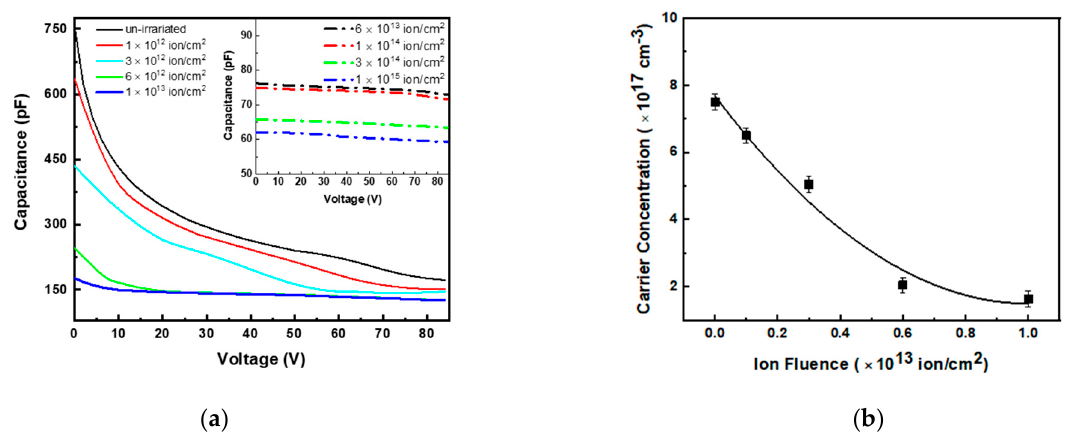
Figure 4. Capacitance–voltage (C–V) curves of un-irradiated and of irradiated diodes at different fluences ( a ). Dopant concentration as a function of ion fluence calculated by C–V measurements ( b ).